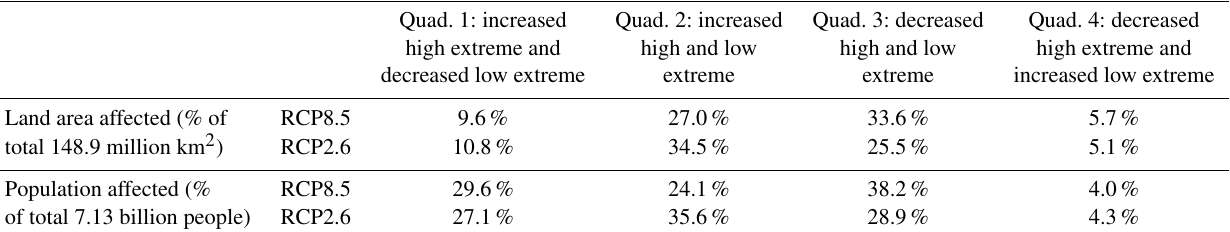
Table 2. Percent of population and land area affected by each high and low extreme change quadrant for the RCP2.6 and RCP8.5 scenarios. Presented percentages are for total global land area and total global population. Hence, the percentages presented for Quads. 1–4 sum up to the 75.9% of global land area and 95.9% of the year 2015 total global population considered in this study.